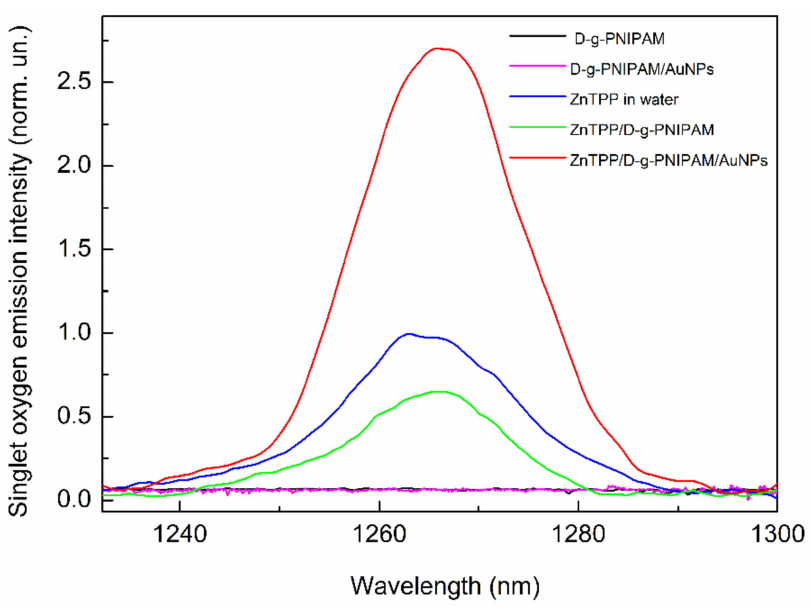
Figure 10. Emission spectra of singlet oxygen for ZnTPP, ZnTPP/D-g-PNIPAM and ZnTPP/D-g- PNIPAM/AuNPs aqueous solutions. The D-g-PNIPAM and D-g-PNIPAM/AuNPs aqueous solutions without ZnTPP demonstrate no emission from singlet oxygen. Excitation: 553 nm; concentrations: ZnTPP—0.001 g/L, D-g-PNIPAM—0.078 g/L, Au—0.077